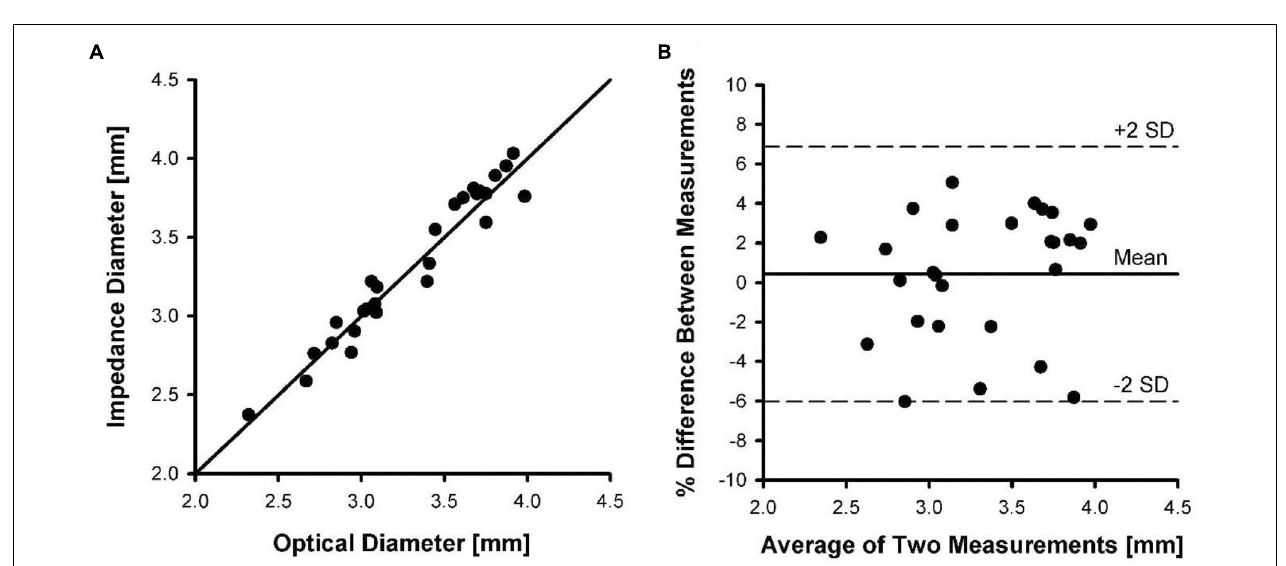
FIGURE 5 | Inner diameters of five pig carotid arteries measured by impedance catheters versus diameters measured optically. Each artery was pressurized from 20 to 120 mmHg in increments of 20 mmHg during measurements. (A) The line of identity between optical diameter and impedance diameter measurements. (B) A Bland-Altman plot of mean of diameter measurements versus percent difference in